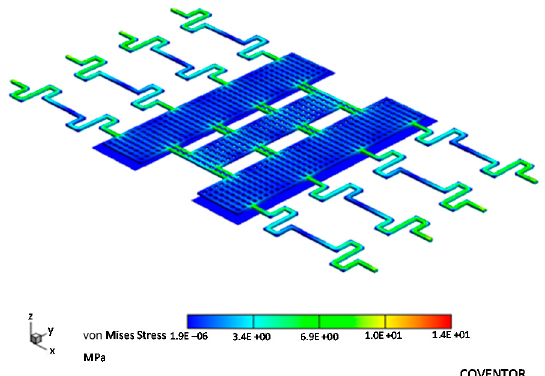
Figure 4. Stress distribution of the micromachined switch.